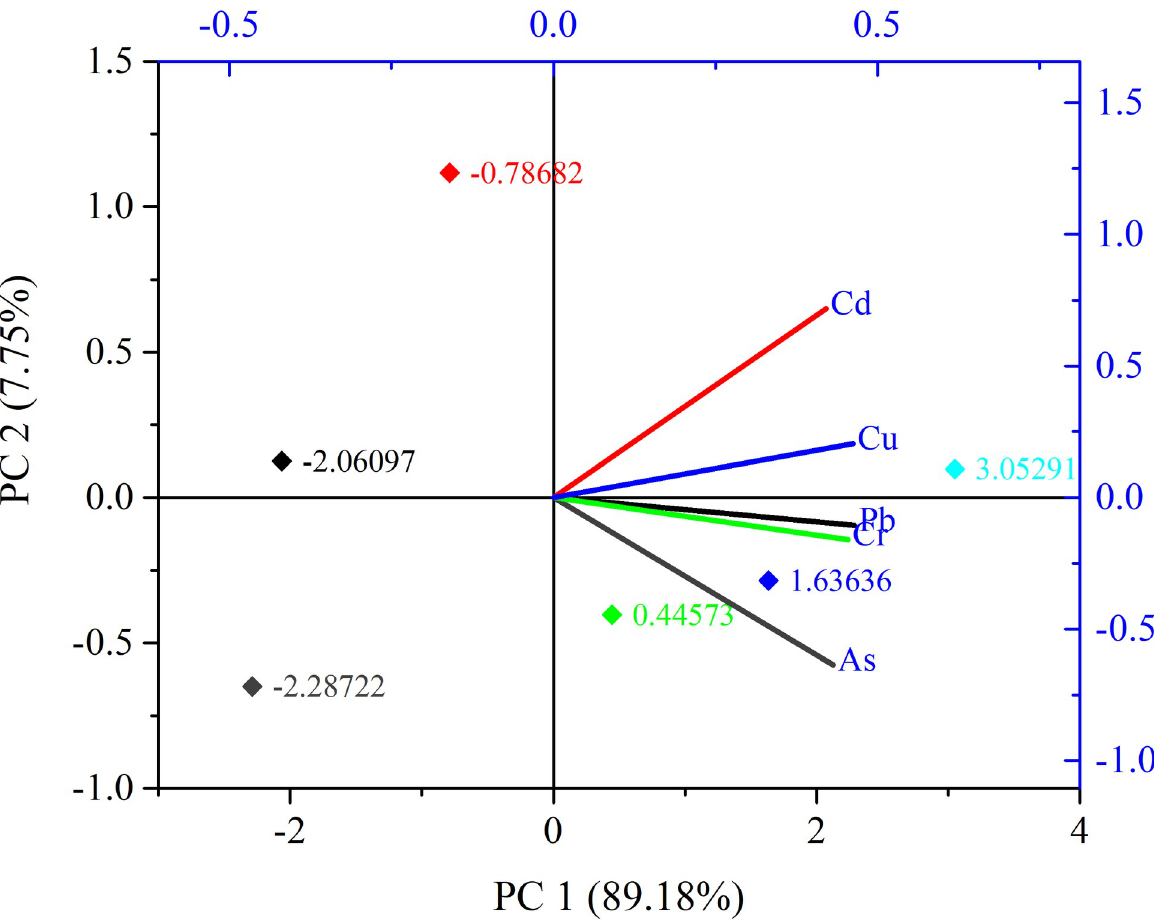
Fig 2. Loading plots of principal component analysis (PCA) of